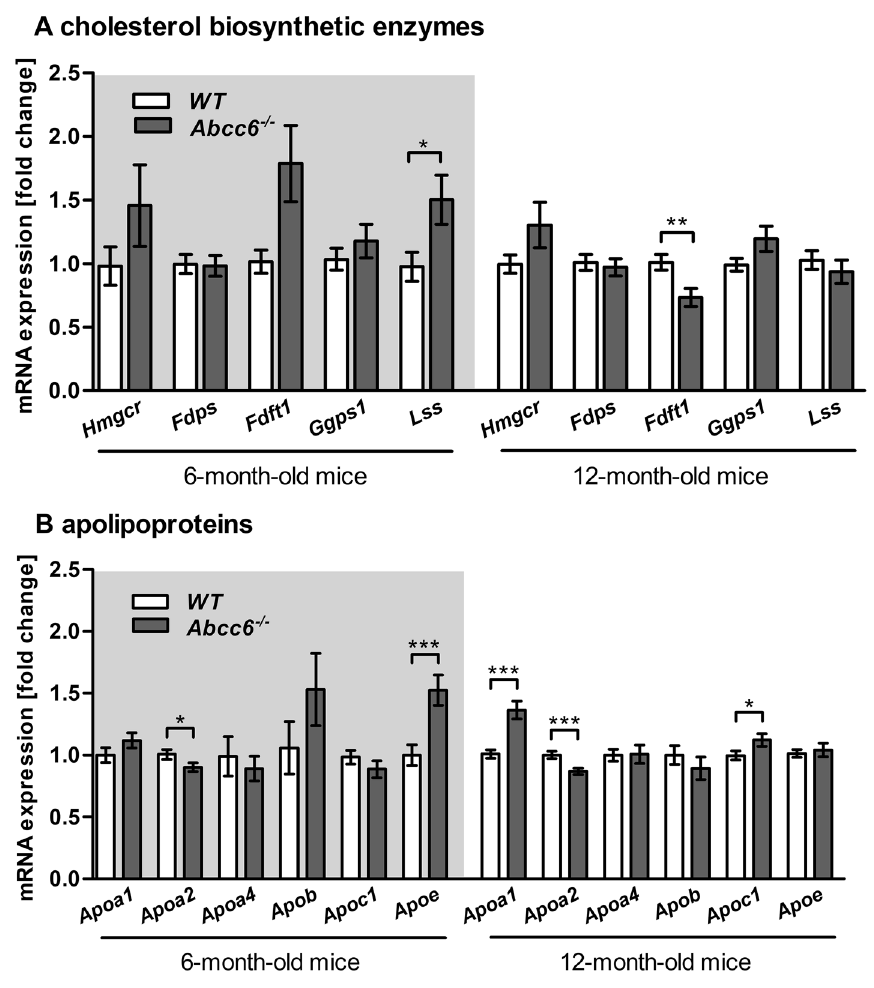
Figure 3. Altered gene expression of cholesterol biosynthetic enzymes and apolipoproteins in Abcc6 knockout mice. ( A ) Relative hepatic gene expression levels of cholesterol biosynthesis enzymes [3-hydroxy-3- methylglutaryl coenzyme A reductase ( Hmgcr ), farnesyl pyrophosphate synthase ( Fdps ), farnesyl-diphosphate farnesyltransferase 1 ( Fdft1 ), geranylgeranyl pyrophosphate synthase 1 ( Ggps1 ) and lanosterol synthase ( Lss )] and ( B ) apolipoproteins ( Apoa1 , Apoa2 , Apoa4 , Apob , Apoc1 and Apoe ) of WT and Abcc6 −/− mice (6-month- old: WT n = 22, Abcc6 −/− n = 25; 12-month-old: WT n = 37, Abcc6 −/− n = 39). Data are fold change of mean ± SD relative to samples of WT; by Student’s t test; *p ≤ 0.05; **p ≤ 0.01; ***p ≤